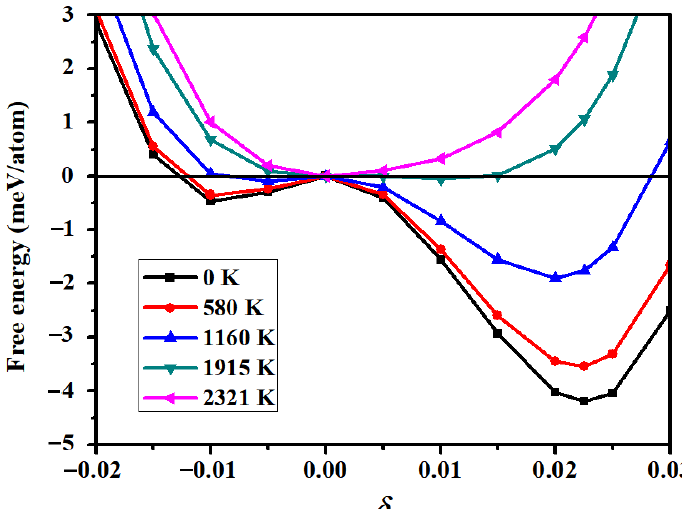
Figure 4. Effect of thermo-electrons on the phase stability of vanadium at 211 GPa. (By the courtesy of Ref. [54]).